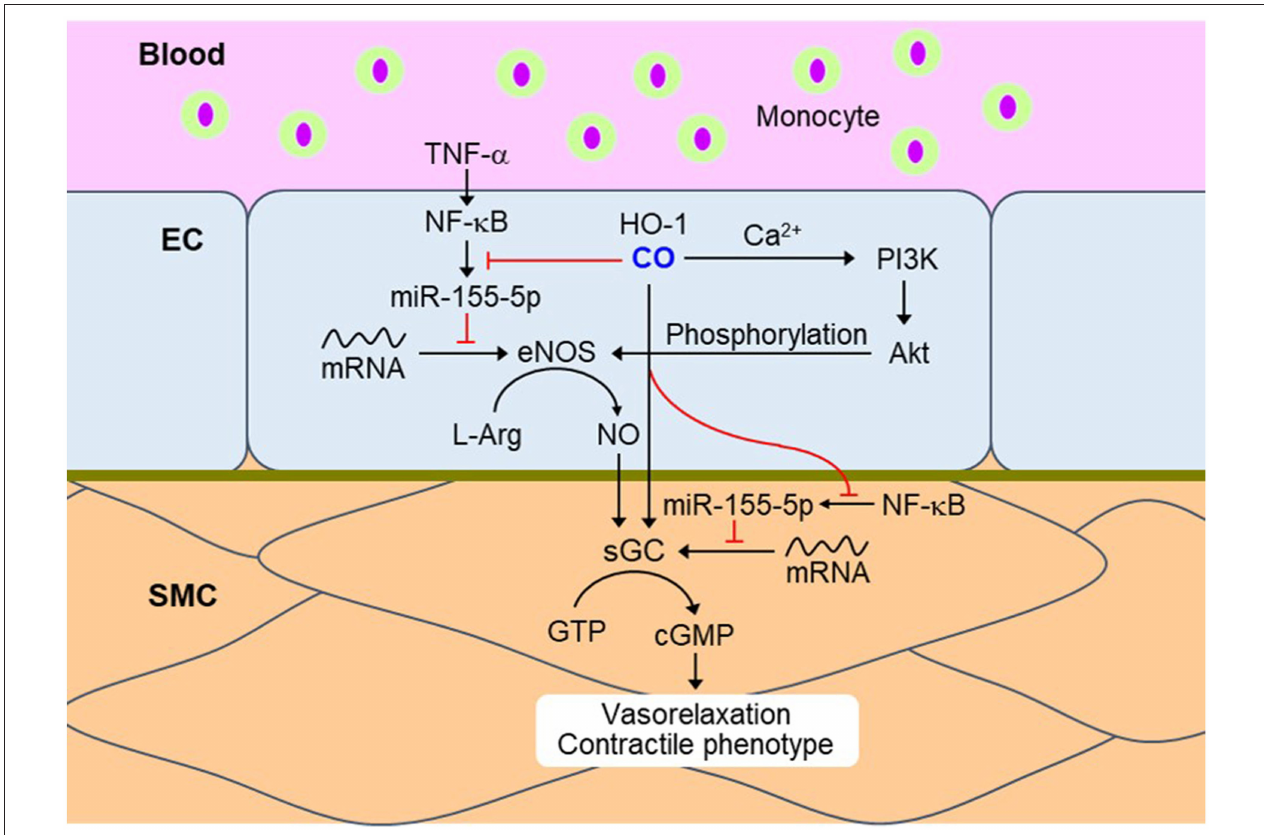
FIGURE 2 | CO momentarily downregulates NF- κ B signaling in ECs and SMCs during the inflammatory condition. Transient HO-1/CO pathway blocks TNF- α -mediated NF- κ B activation and subsequent miR-155-5p biogenesis. miR-155-5p downregulates eNOS and sGC by targeting their transcripts, resulting in vasoconstriction. Therefore, inhibition of NF- κ B-responsive miR-155-5p biogenesis by CO may recover vasorelaxation and contractile phenotype. Red dash: blockade signal by CO. NF- κ B, nuclear factor- κ B; EC, endothelial cell; SMC, smooth muscle cell; TNF- α , tumor necrosis factor- α ; eNOS, endothelial nitric oxide synthase; L-Arg, L-arginine; sGC, soluble guanylyl cyclase; GTP, guanosine triphosphate; cGMP, cyclic guanosine